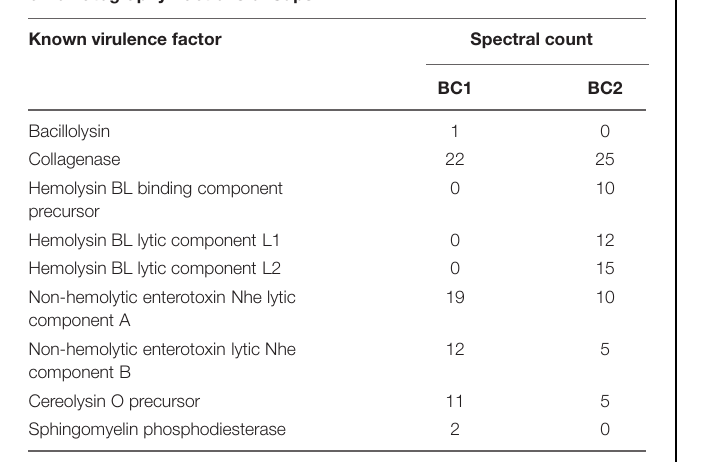
TABLE 2 | Pathogenic factors identified in the toxic size-exclusion chromatography fractions of Sups.